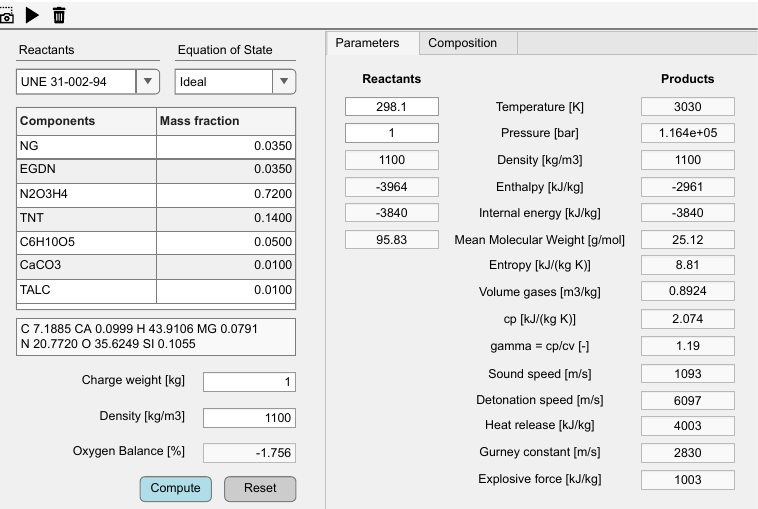
Figure 3. Interface of the assistant for the calculation of the theoretical thermodynamic properties of explosives and explosive